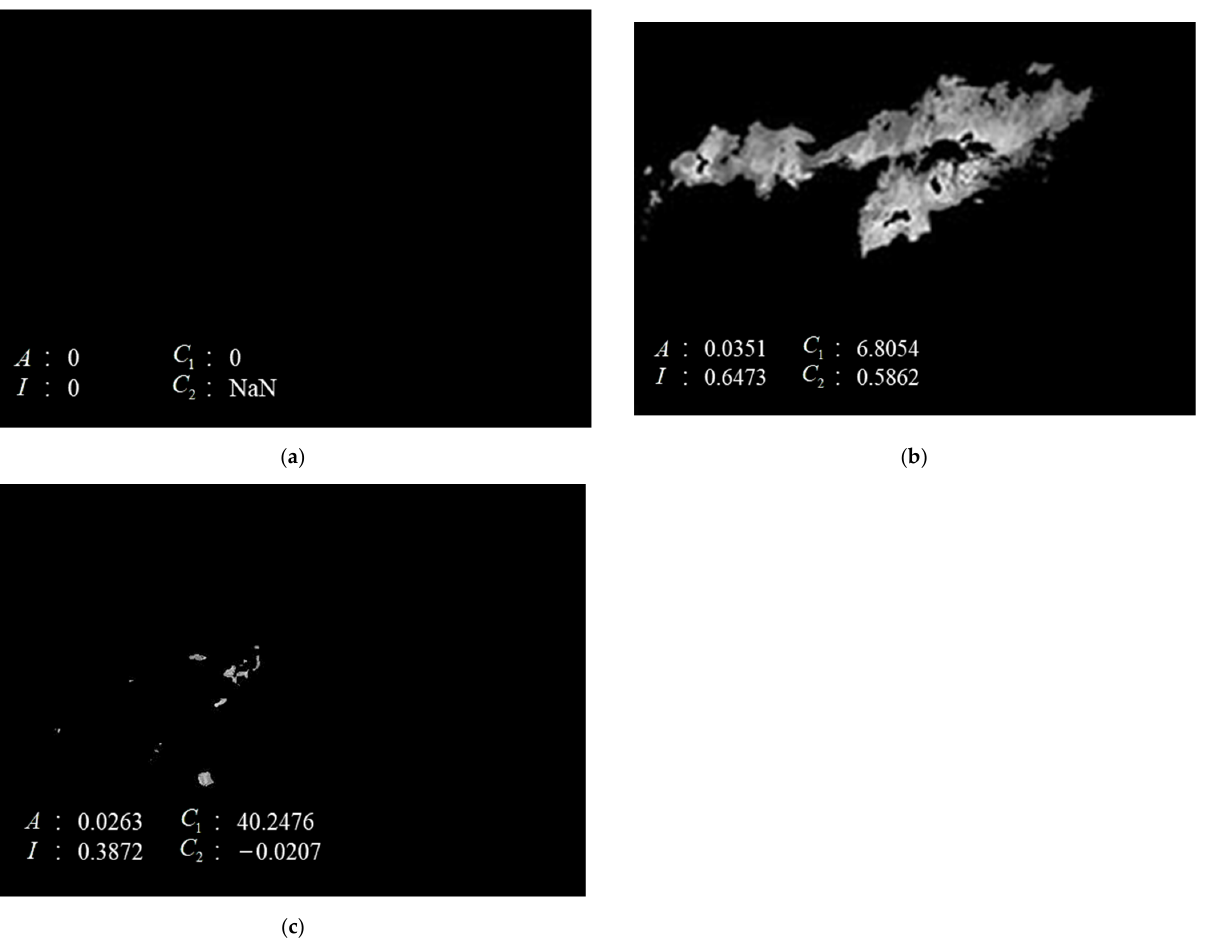
Figure 9. Gray scale image: ( a ) forest image without fire; ( b ) forest image with fire; ( c ) forest image with fire-like interference. Table 2. Gray level co-occurrence matrix feature vector.